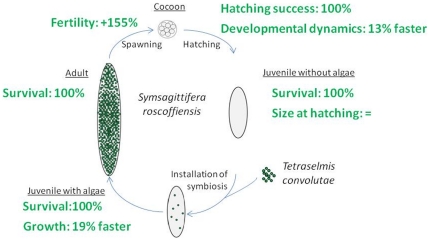
Summary of the impact of low pCO2 (27063 µatm) on S. roscoffensis life cycle.